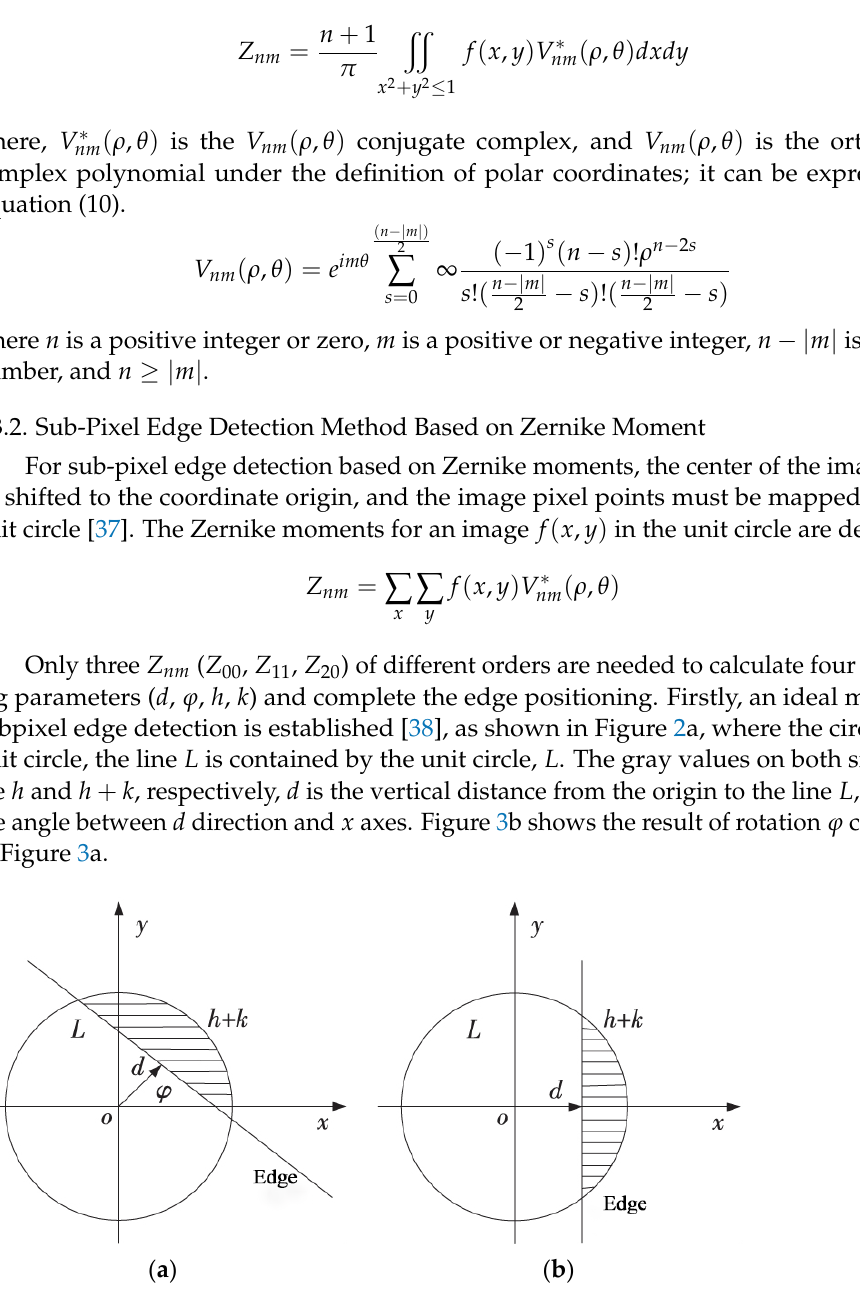
Figure 3. Ideal model for sub-pixel edge detection: ( a ) Original edge image; ( b ) Edge image after rotation.